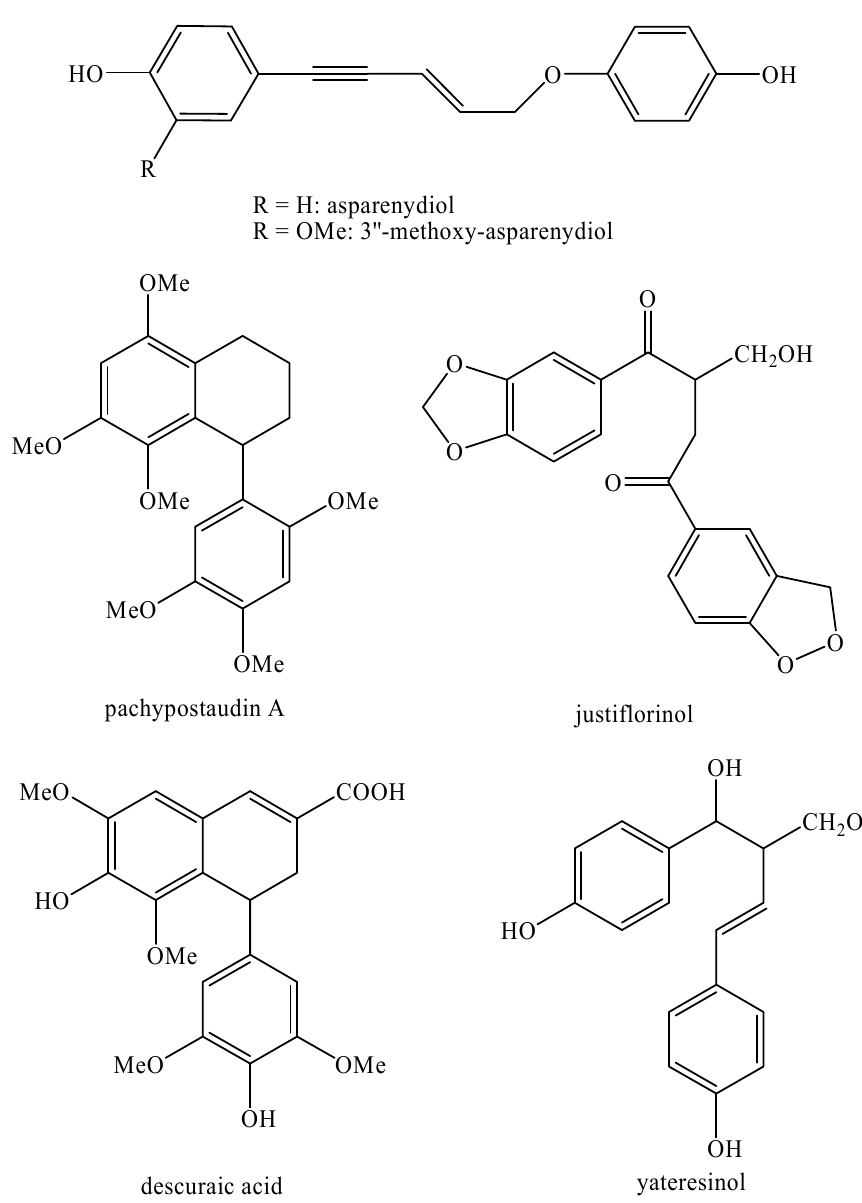
Figure 17. Isolated nor -lignans in the plant kingdom—part 16.